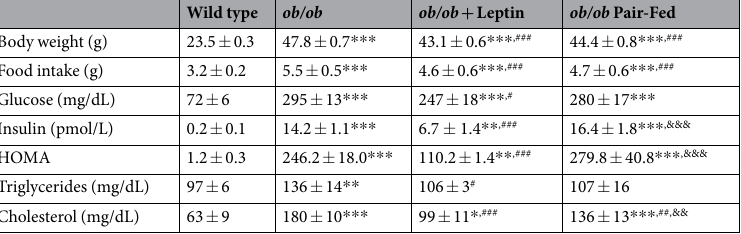
Table 1. Body weight, food intake and serum analysis in ob/ob mice. Effect of leptin replacement. HOMA, homeostatic model assessment. Data presented as mean ± SEM. Differences were analyzed by ANOVA followed by LSD tests. * P < 0.05, ** P < 0.01 and *** P < 0.001 vs wild type; # P < 0.05, ## P < 0.01 and ### P < 0.001 vs ob/ob ; && P < 0.01 and &&& P < 0.001 vs ob/ob + leptin. n = 6–10 per